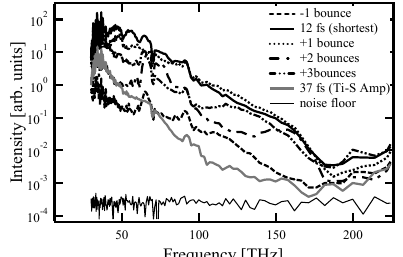
Fig. 3 Fourier transformed spectrum of the infrared pulse observed with THz-ABCD. Inset shows the temporal electric-field